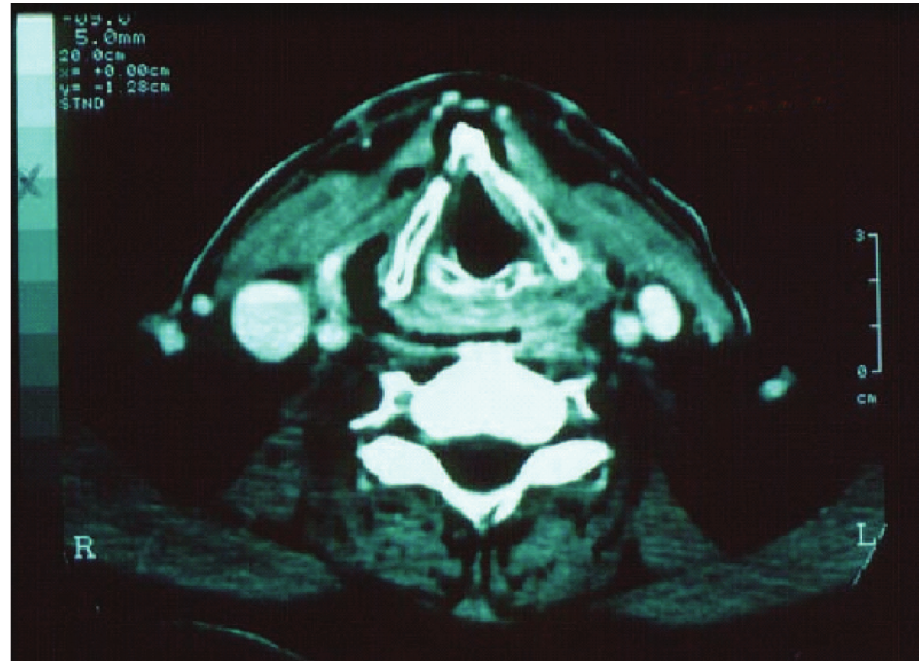
Figure 2 - Computed tomography of the neck showing diffuse thickening and infiltration of the cutis and subcutis; diffuse enhancement of the superficial and deep cervical fasciae; thickening of the platysma, sternocleidomastoid, and strap muscles; and air and small amounts of fluid buildup in multiple neck